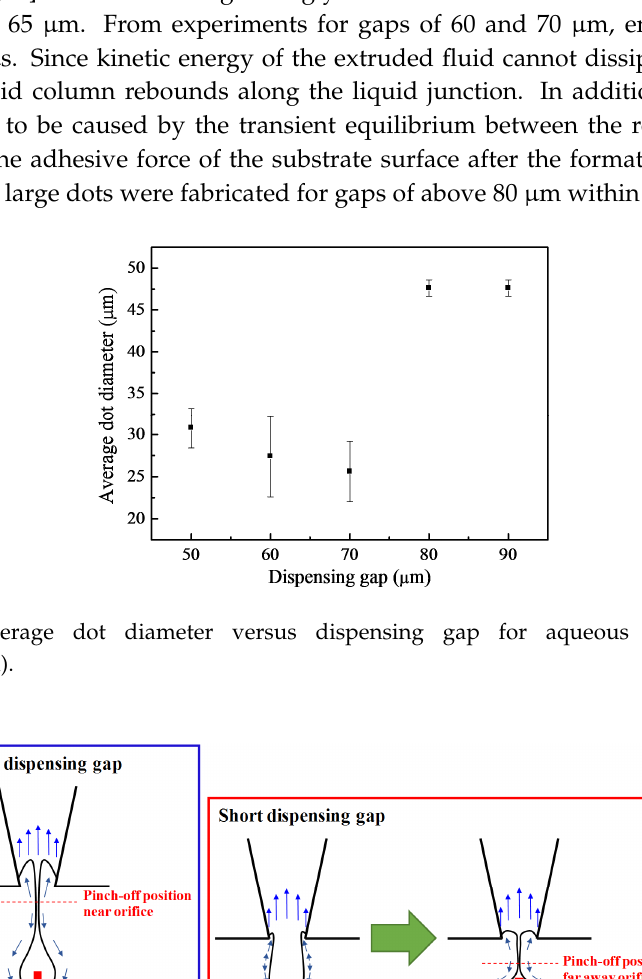
Figure 9. Schematic illustrations of two fluid dispensing dynamics for narrow dispensing gaps.